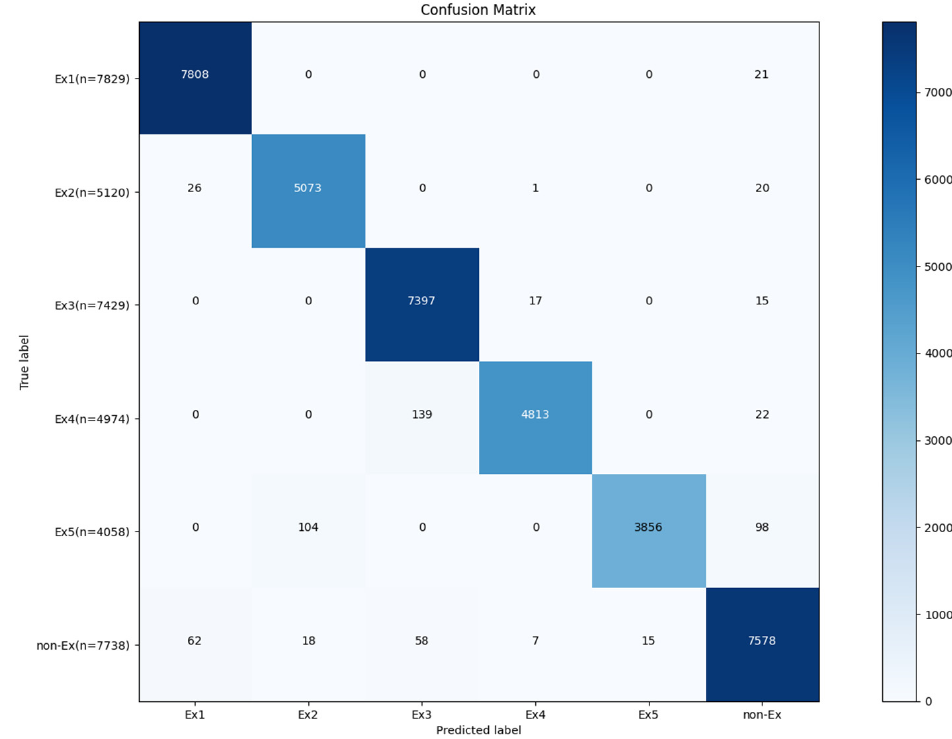
Figure A8. Confusion matrix for upper joint position input model.